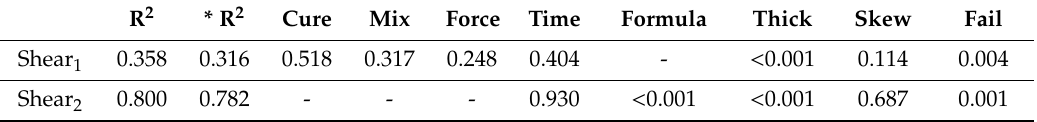
Table 4. General linear model significance (p)